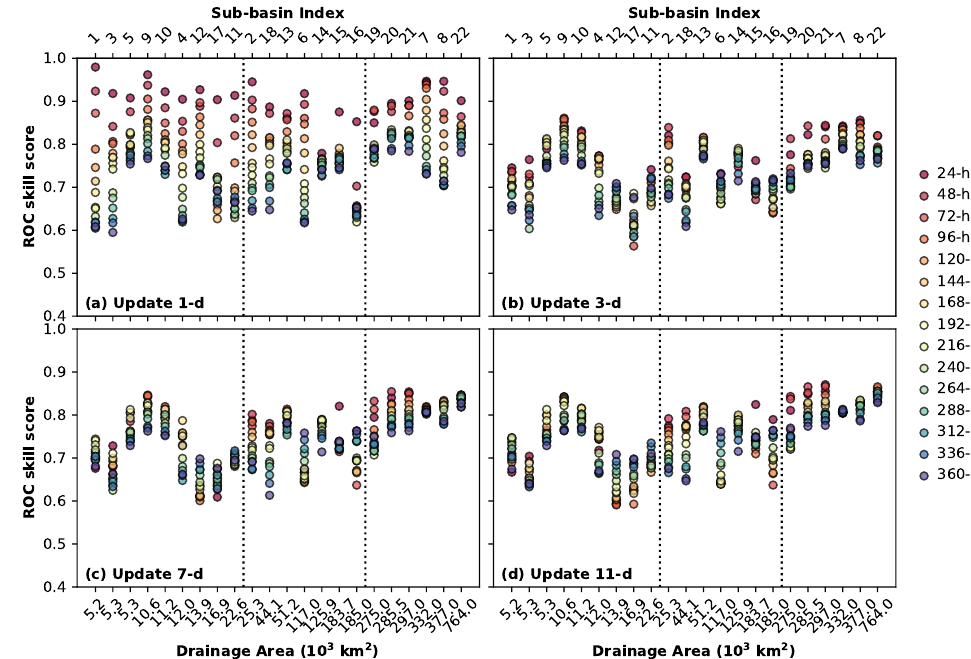
Figure 2. ROC skill score for 22 sub-basins of the Tocantins-Araguaia Basin for 15 lead times as a function of drainage area for streamflow with a probability level of 0.9. MHD-INPE update every ( a ) 1 d, ( b ) 3 d, ( c ) 7 d, and ( d ) 11 d to the ECMWF ensemble. The vertical dotted lines divide the drainage area into small, medium, and large